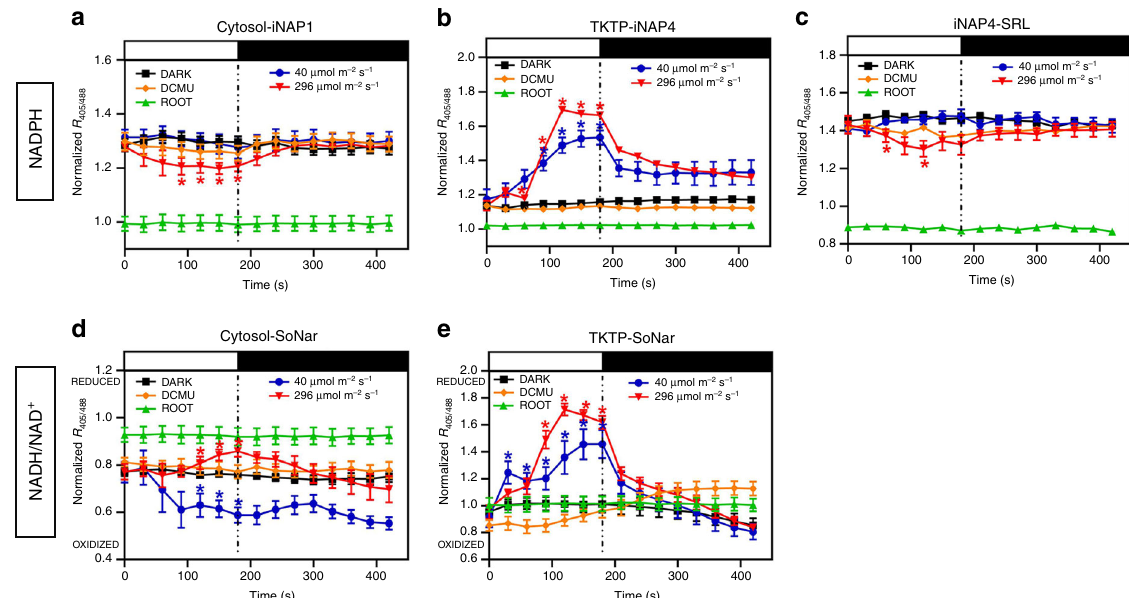
Fig. 2 Light responses of iNAP and SoNar sensors in untreated cotyledon with 40 µ mol m − 2 s − 1 or 296 µ mol m − 2 s − 1 illumination or cotyledon pre- treated with DCMU or root at 296 µ mol m − 2 s − 1 illumination. The normalized R 405/488 shifts of a cytosolic iNAP1, b stromal iNAP4, c peroxisomal iNAP4, d cytosolic SoNar, and e stromal SoNar in mesophyll of 10-day-old cotyledon in response to illumination with an interval of 30 s are shown. Illumination up to 180 s is represented by white bars, and the period after light was turned off is indicated by black bars ( n = 5; error bars ± SEM). All results shown were normalized with cytosol-iNAPc, TKTP-iNAPc, and iNAPc-SRL, respectively. Asterisks indicate that the differences ( P < 0.05) between results from the dark condition and 40 µ mol m − 2 s − 1 or 296 µ mol m − 2 s − 1 illumination are statistically signi fi cant as determined by a paired t -test.